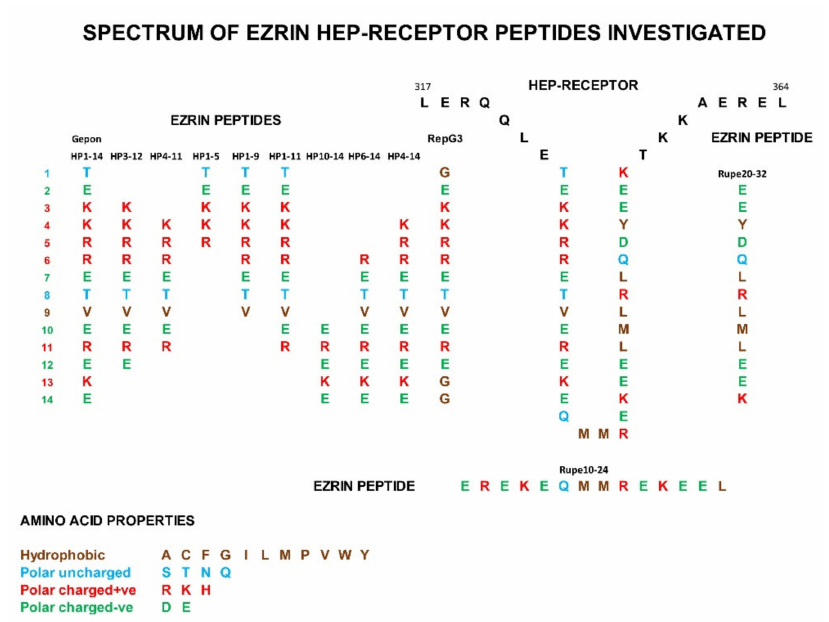
Figure 2. The electrostatically charged Hep-receptor in the α domain of human ezrin, comprises of two four-turn anti-parallel α -helices. Peptides from 5 to 14 amino acids in length that mimic parts of the Hep-receptor were synthesized and investigated for biological